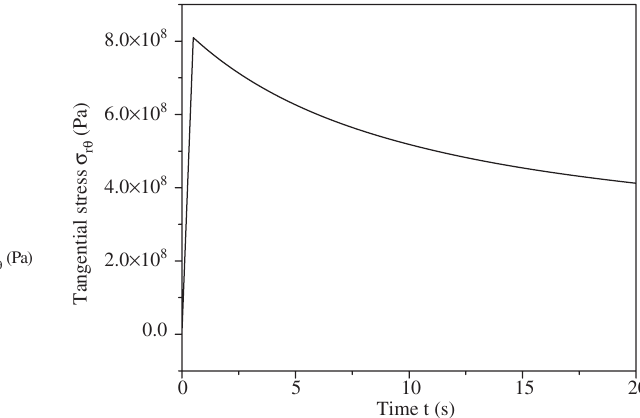
Figure 25 Contour map of tangential stress in the FGM hollow cylin- der, where t = 0.5 s.